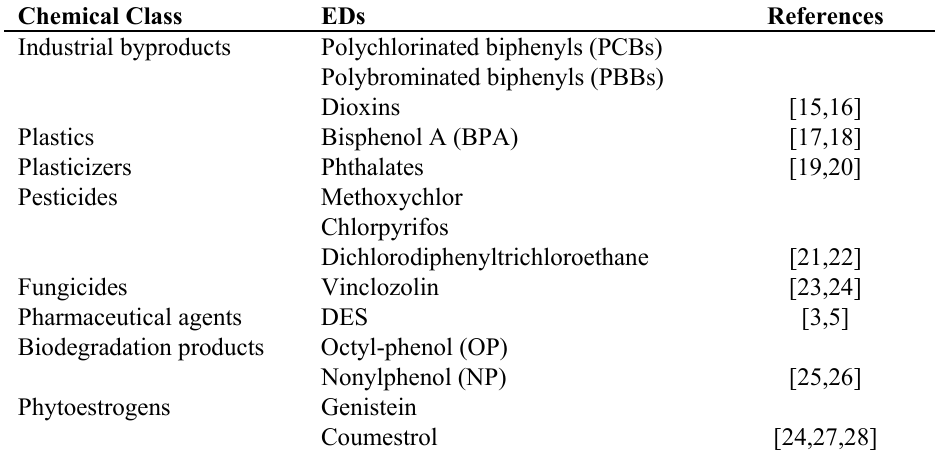
Table 1. List of estrogenic